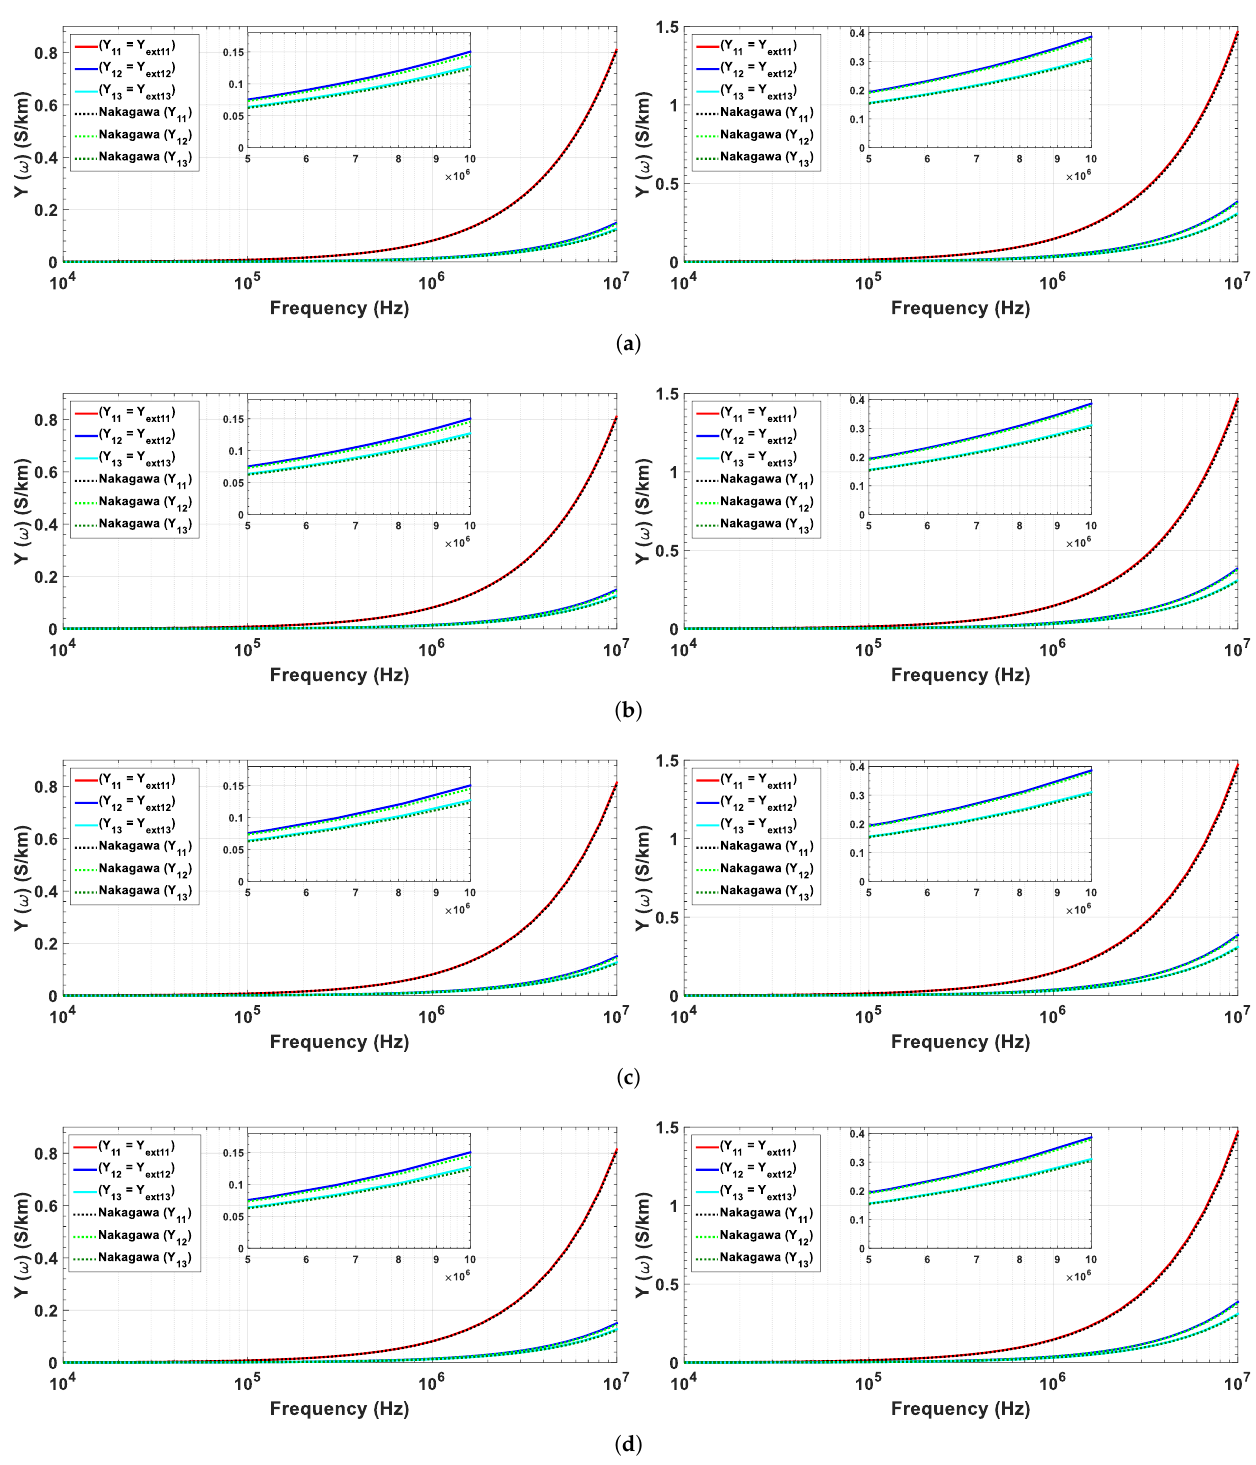
Figure 8. Transversal admittance (only elements Y 11 , Y 12 and Y 13 ) computed for the single-circuit TL of Figure 6a (left) and double-circuit TL of Figure 6b (right) located on soils with ρ 0 of: ( a ) 500 Ω · m; ( b ) 1000 Ω · m; ( c ) 5000 Ω · m and ( d ) 10,000 Ω ·